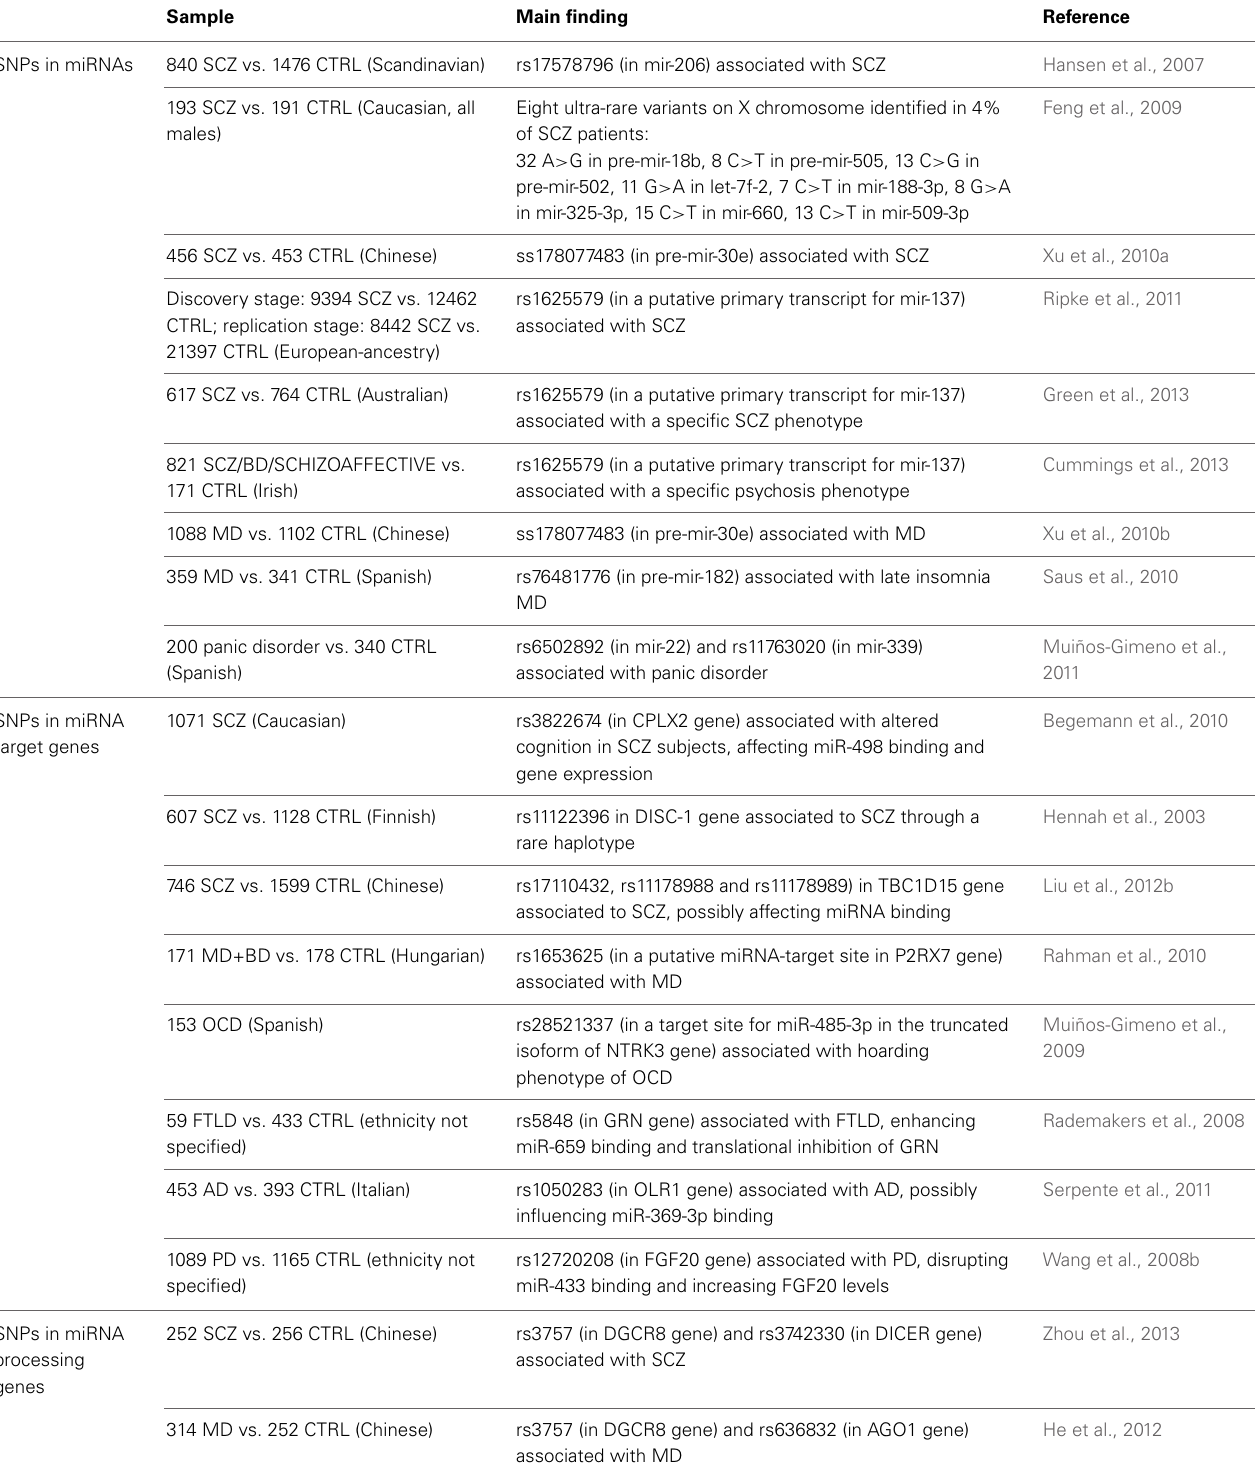
Table 3 | Genetic studies on microRNA-related genes in psychiatric and neurologic disorders.